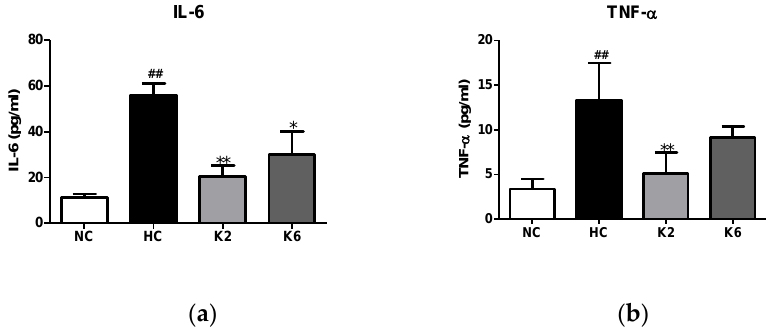
Figure 4. Effect of L. plantarum treatments on the production of cytokines of small intestine mucosa in the HFHF diet rat. Production concentrations of ( a ) IL-6 and ( b ) TNF- α in the culture supernatant. Values represent the mean ± SEM. ## p < 0.01 vs. control group (NC), * p < 0.05 and ** p < 0.01 vs. HC group. NC, normal diet control; HC, HFHF diet control; K2, HFHF diet with K2; K6, HFHF diet with K6; IL-6, interleukin-6; TNF- α , tumor necrosis factor-alpha.